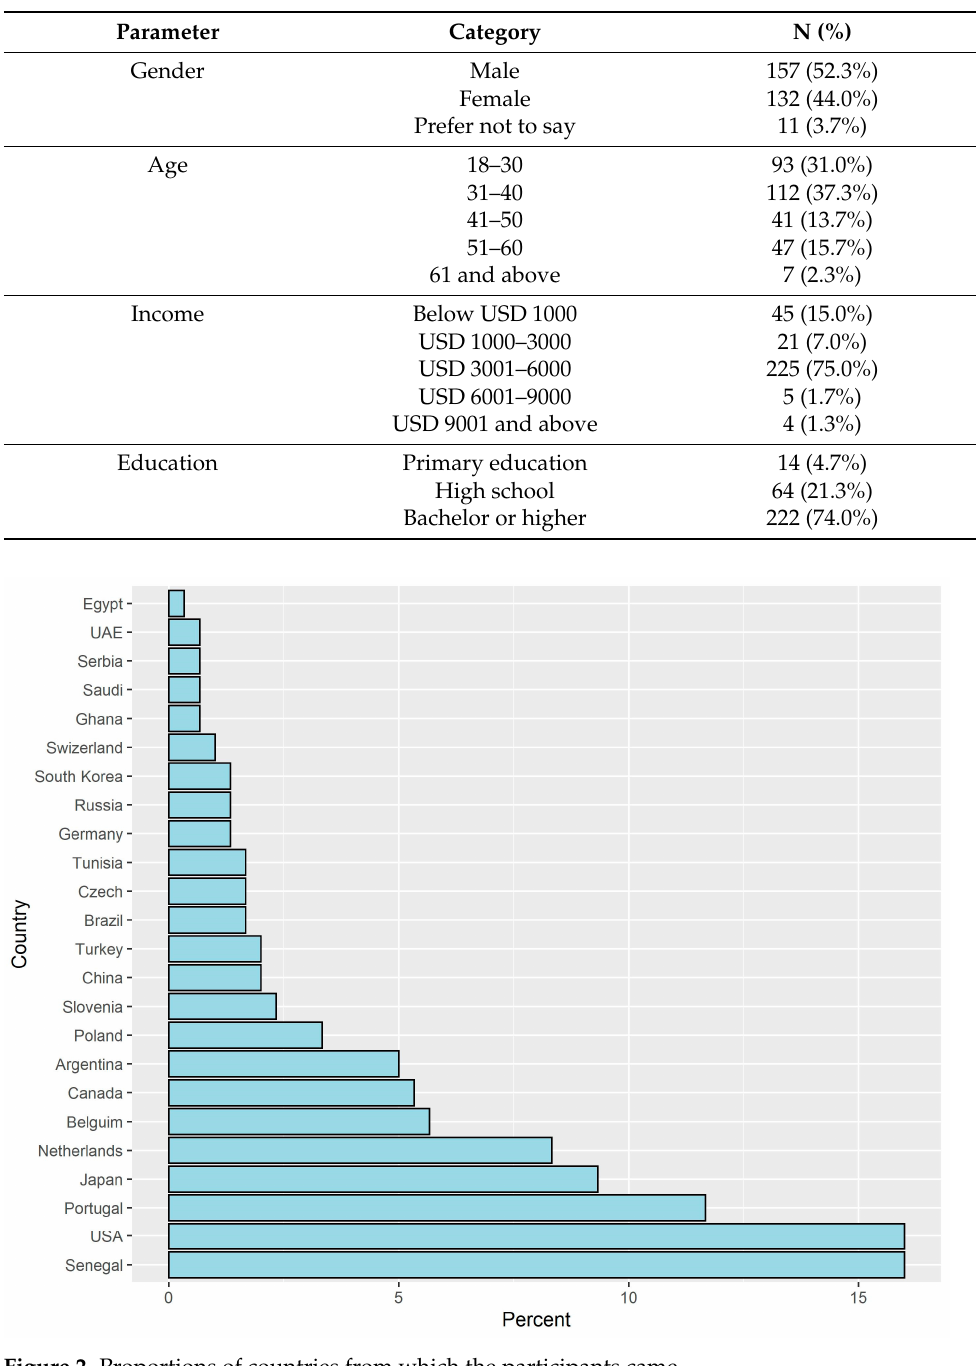
Figure 2. Proportions of countries from which the participants came.